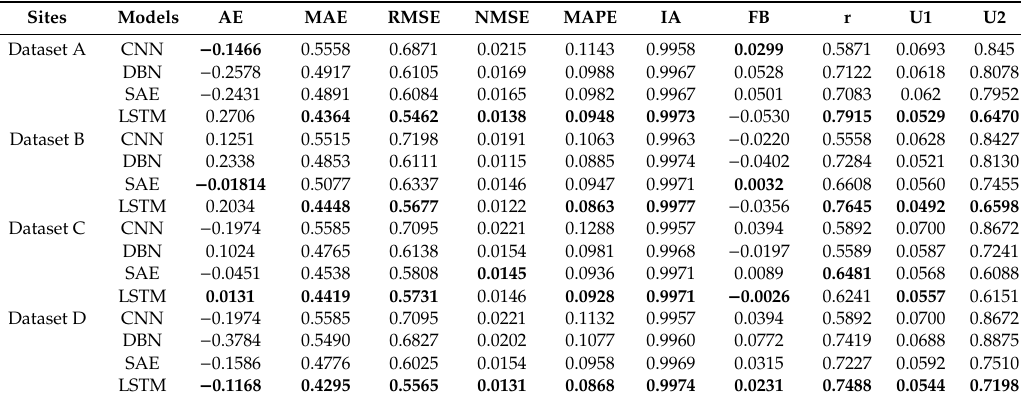
Table 6. Forecasting results of the four deep learning algorithms at four